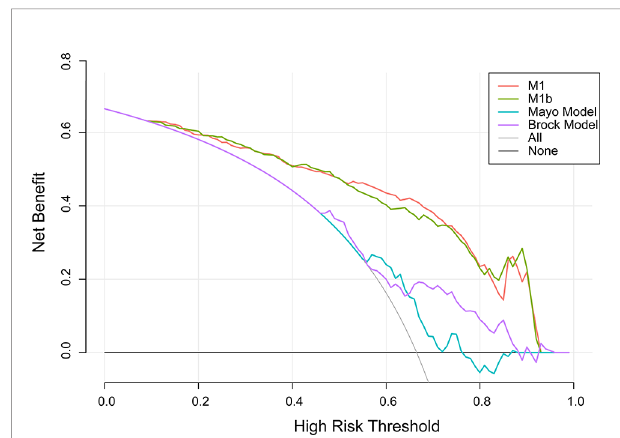
FIGURE 3 | Decision curve analysis for lung cancer prediction models in the validation cohort. Thick gray oblique line the strategy of treating all patients; thick black horizontal line the strategy of treating no patients. The line with the highest net bene fi t at a speci fi c threshold probability will lead to the best clinical